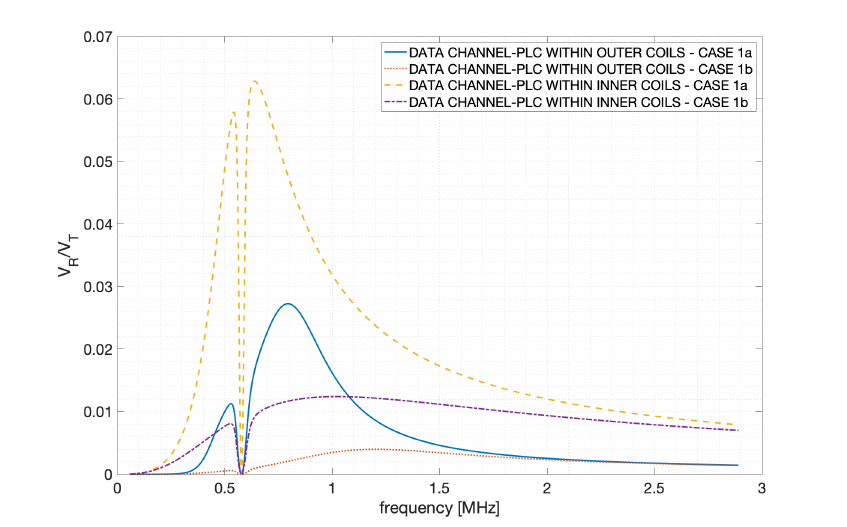
Figure 12. Transfer function comparison for the data channel, Case Study